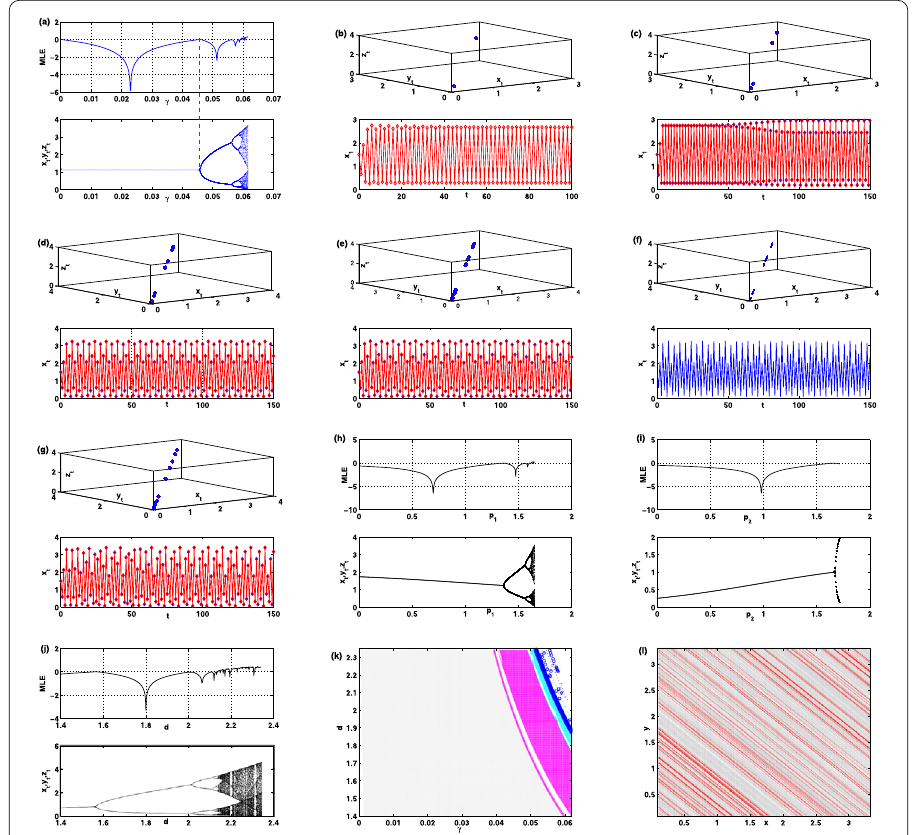
Figure 1 The complex analysis of the system (16) via bifurcations, phase portrait of the period cycles and chaotic attractor, time series and Lyapunov exponent when varying the parameter values of γ , p 1 , p 2 and d